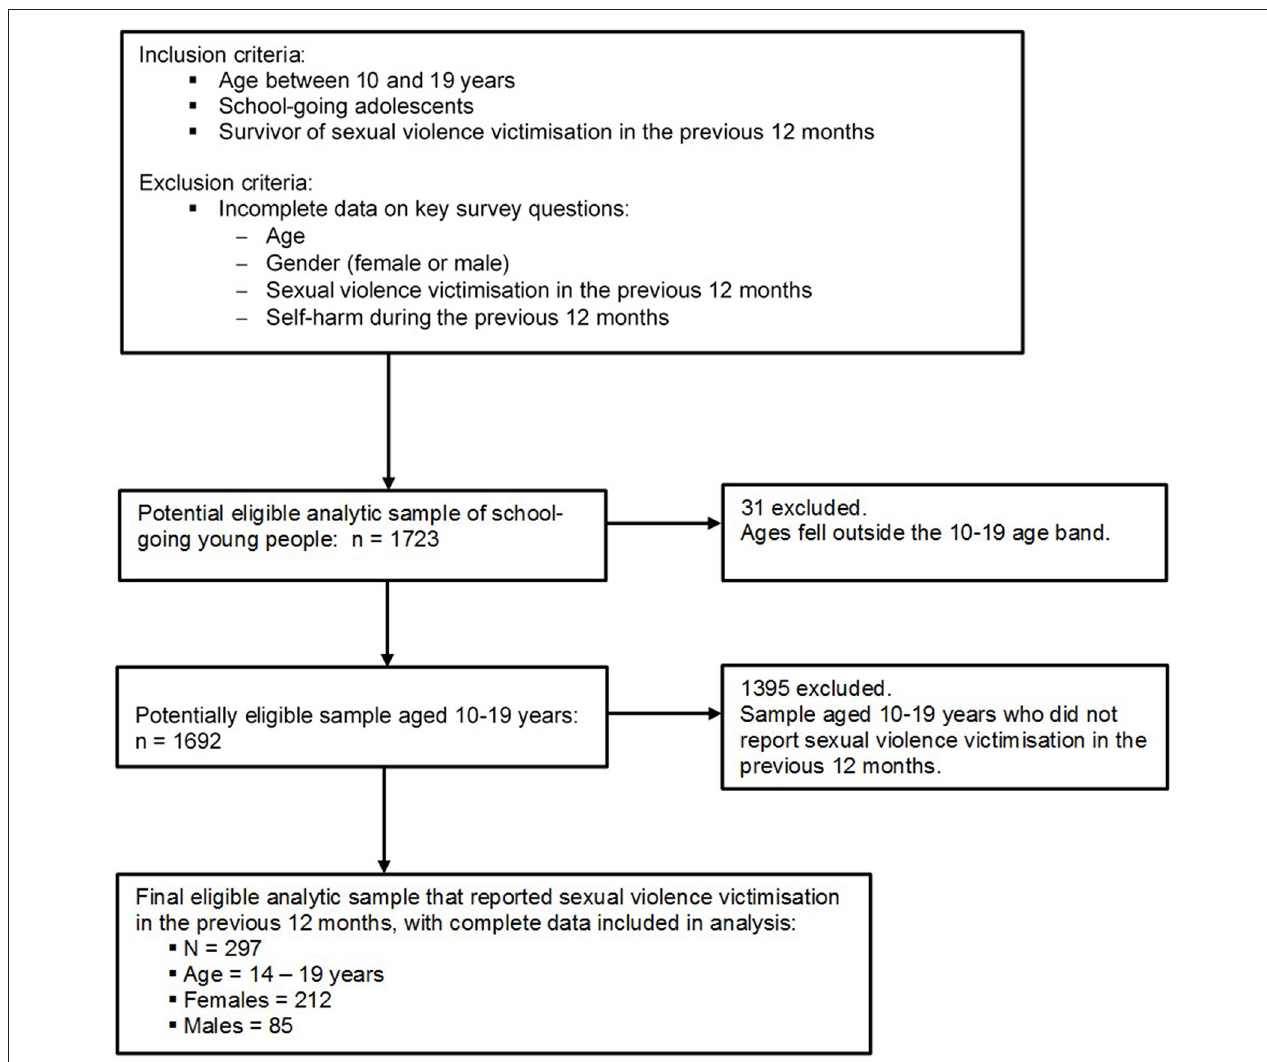
FIGURE 1 | Flow diagram of analytic sample selection process and